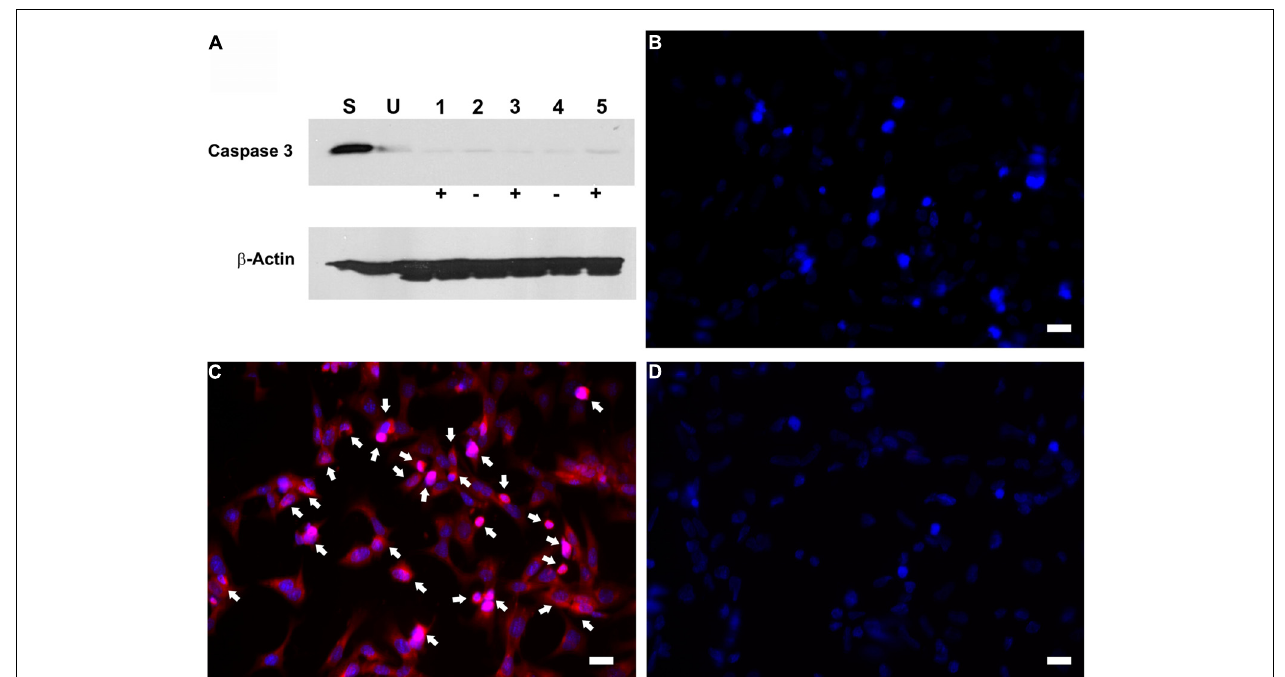
treated with Dox. (D) Untransfected cells treated with Staurosporine (positive control). Arrows point to apoptotic cells. S = Untransfected cells treated with Staurosporine for 4 h ; U = Untransfected cells; 1 = Transfected cells treated with Dox only for 48 h; 2 = Transfected cells not treated with Dox for 24 h; 3 = Transfected cells treated with Dox for 24 h; 4 = Transfected cells not treated with Dox for 48 h; 5 = Transfected cells treated with Dox for 48 h. Bar = 10 μ m.